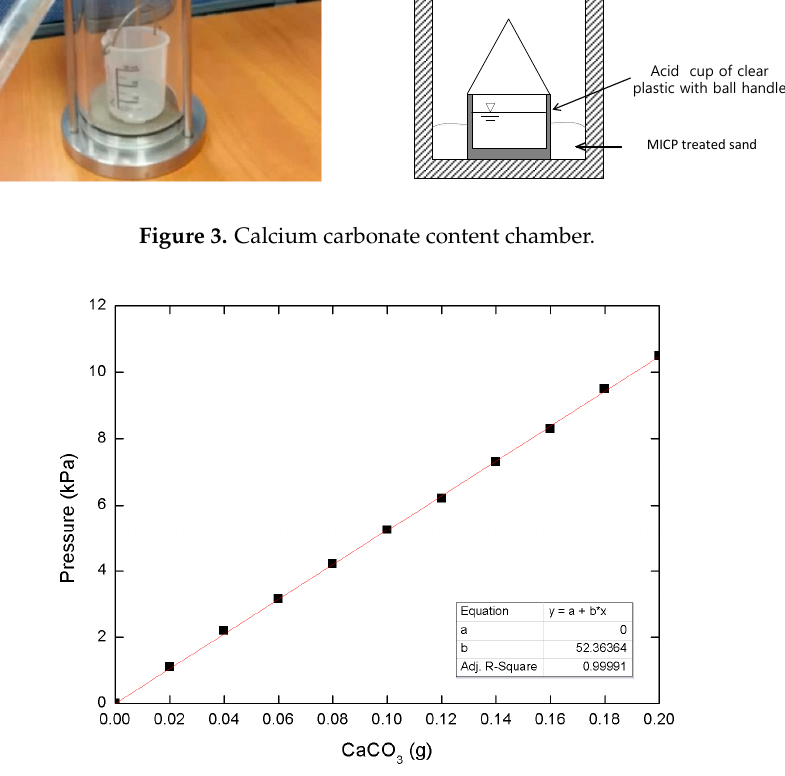
Figure 4. Gas pressure–CaCO 3 relationship.